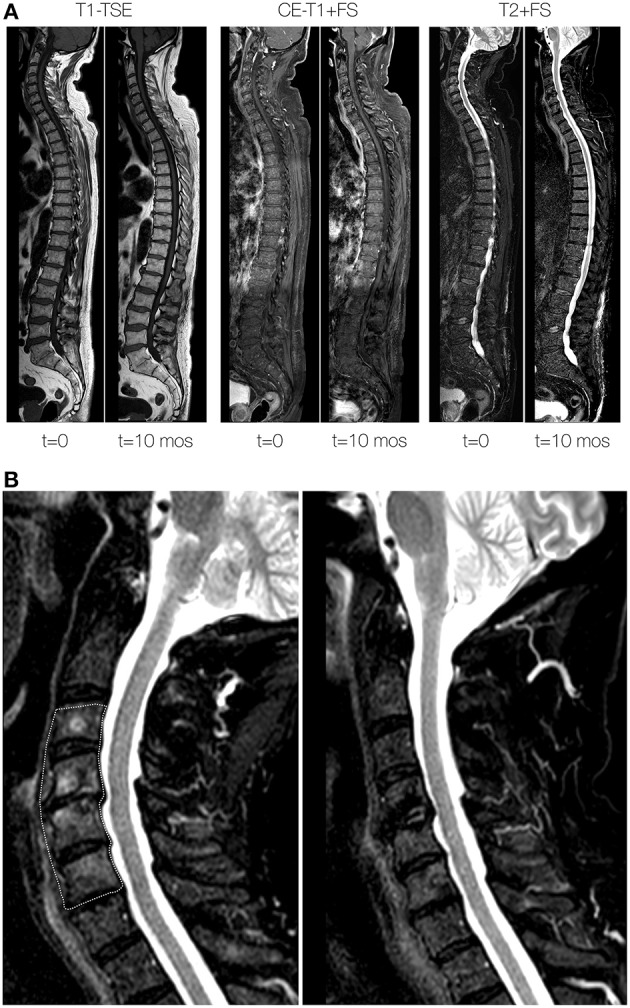
Vertebral lesions at baseline and during follow-up. (A) Total spine sagittal reconstructions of T1-weighted turbo spin-echo (TSE; left 2 panels), contrast-enhanced water-selective T1-weighted TSE (middle two panels) and T2-weighted sequences (right two panel) at baseline (t = 0) and 10 months (t = 10 mos) after initiation of treatment. At baseline, note the mottled appearance and lower signal intensity of the vertebral bodies on the T1-weighted sequences at baseline. At 10 months after treatment the signal intensity has returned to near normal signal intensity. (B) Zoomed detail of T2-weighted sequences at baseline (left) and 10 months after treatment (right) of the cervical spine. The area outlined by the dashed area at baseline signifies abnormally high signal intensity of the vertebral bone marrow, which returned to normal values at 10 months after treatment.